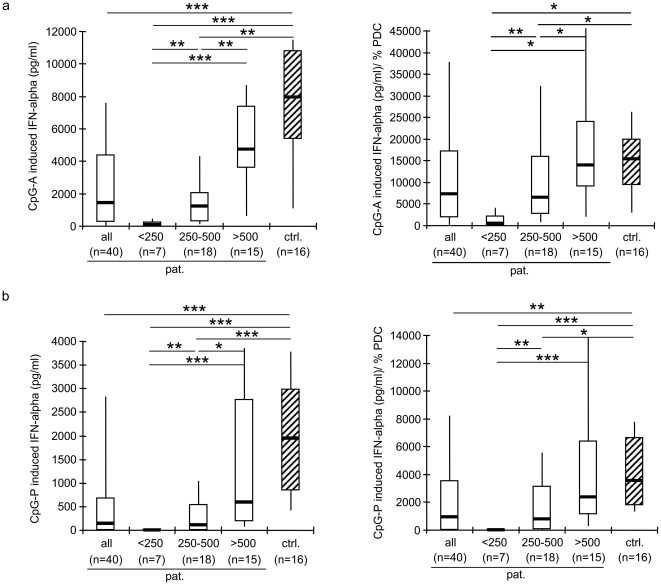
Deficits in interferon (IFN) alpha production in HIV-1 infected patients (pat.) versus control donors (ctrl.).Peripheral blood mononuclear cells (PBMC) were exposed to (a) the CpG-A oligonucleotide 6016 (0.75 µM) and (b) the CpG-P oligodeoxynucleotide 21798 (0.25 µM) for 20 hours (h). The IFN-alpha production is given before and after normalization for the percentage of plasmacytoid dendritic cells (PDC). The data of HIV-1 infected patients were also analyzed for samples with CD4+ T cell counts below 250/µl (<250), between 250–500/µl (250–500), and above 500/µl (>500). Data are presented as median, interquartile ranges (boxes), and 10% and 90% values (whiskers). *p<0.05, **p<0.01, ***p<0.001 (Mann-Whitney test). Part of the data were presented in another study [31]. Similar data were obtained using S-27609 (data not shown).